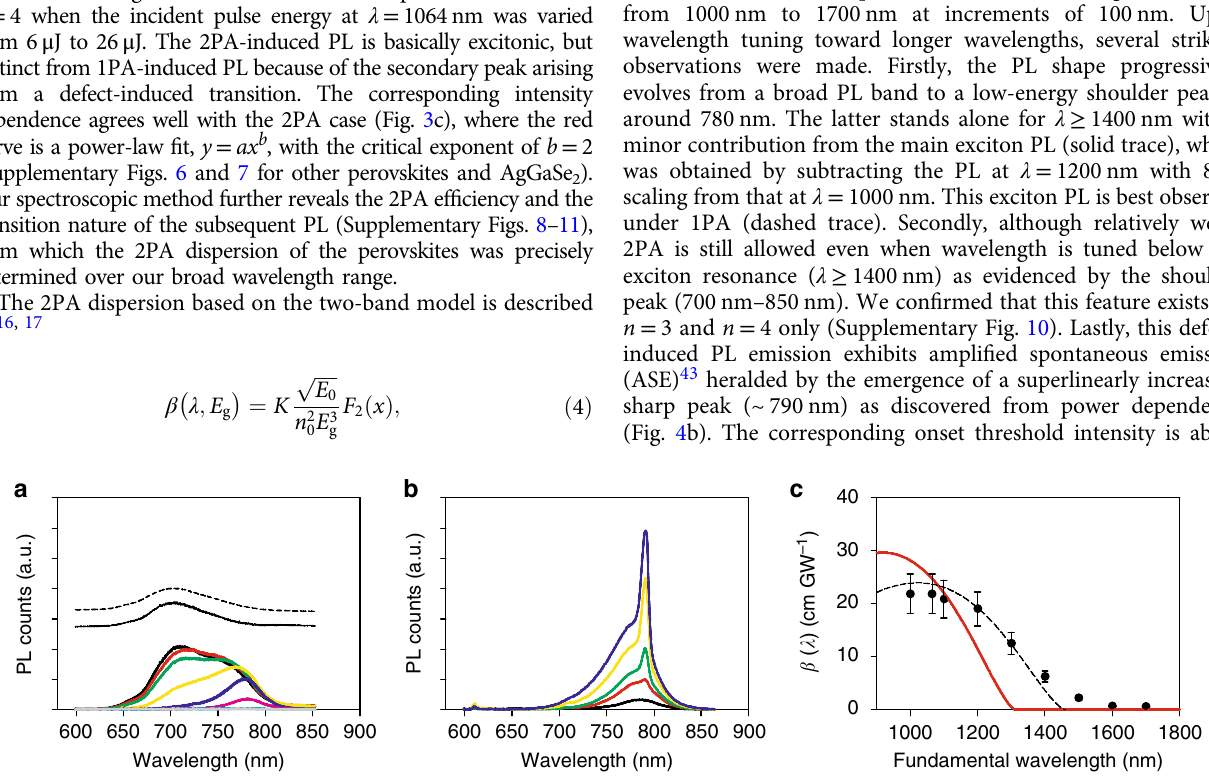
Fig. 4 Two-photon-absorption-induced photoluminescence and two-photon absorption dispersion of n = 4. a PL spectra from n = 4 under two-photon absorption (2PA) for different excitation wavelengths from 1.0 μ m ( black ) to 1.7 μ m ( grey ) at increments of 0.1 μ m (ascending wavelengths correspond to the color sequence black , red , green , yellow , blue , purple , cyan , grey ). The major exciton PL (vertically translated for clarity) is identi fi ed by spectral subtraction, which is essentially the same as the one-photon-absorption-induced photoluminescence (PL, dashed trace ) using frequency-tripled Nd:YAG radiation (355 nm). b Ampli fi ed spontaneous emission of the sharp peak (~ 790 nm) from the low-energy shoulder of n = 4 when the exciton state is resonantly excited by 2PA with excitation energy ranging from 10 μ J ( black ) to 40 μ J ( blue ) at increments of 10 μ J (ascending excitation energies correspond to the color sequence black , red , green , yellow , blue ). c Experimental β ( λ ) ( dots ) where error bars arise from uncertainty in the powder size. The theoretical β ( λ ) ( red curve ) corresponds to Eq. (4) using K = 5000 and the fundamental bandgap, E g = 1.89 eV. The dashed curve is Eq. (4) using the optical gap (~ 1. 7 0 eV) as a band-dispersion parameter with K =